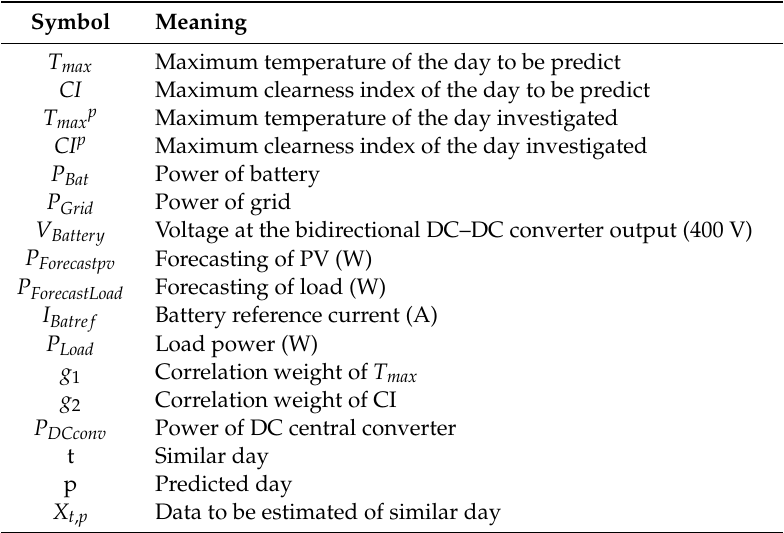
Table A1. A list of mathematical symbols.